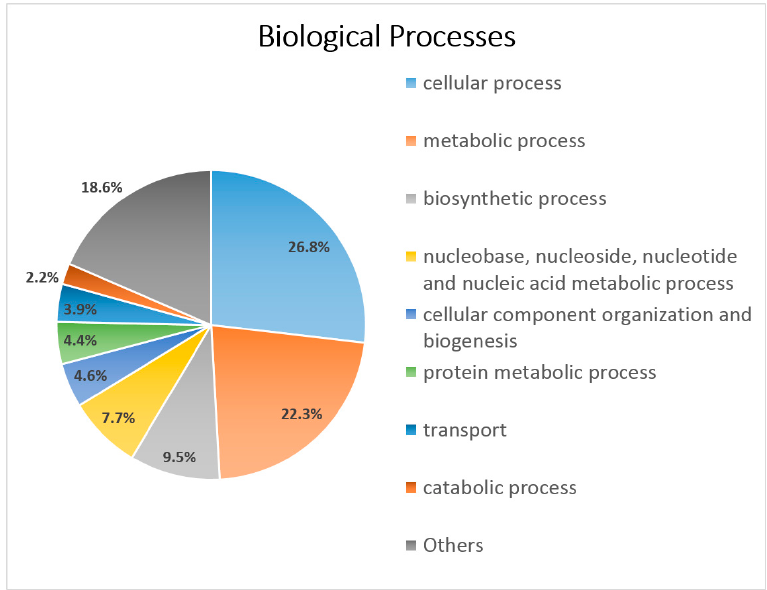
Figure 4. Subcategories of GOs identified by CateGOrizer within the Biological Processes over the whole set of predicted genes.